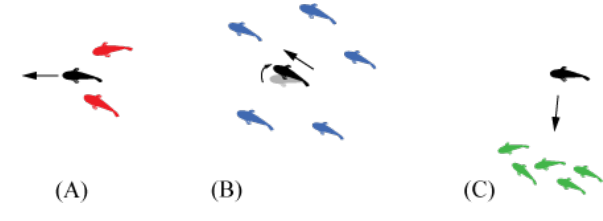
Figure 2. Basic rules of the SPP model applied on a focus agent (black fish): collision avoidance (A), polarization (B), aggregation (C); modified from Vicsek & Zafeiris